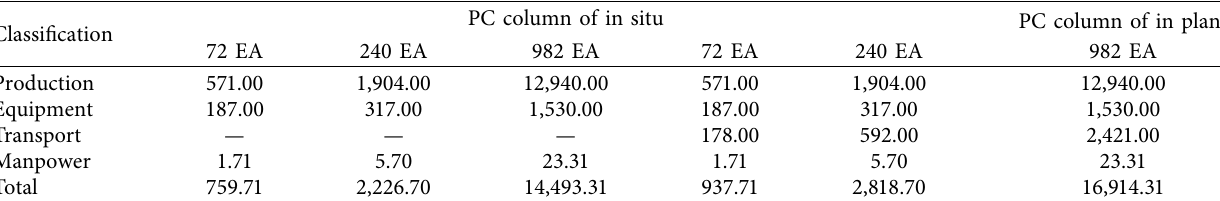
Table 3: CO 2 emissions in PC column by production